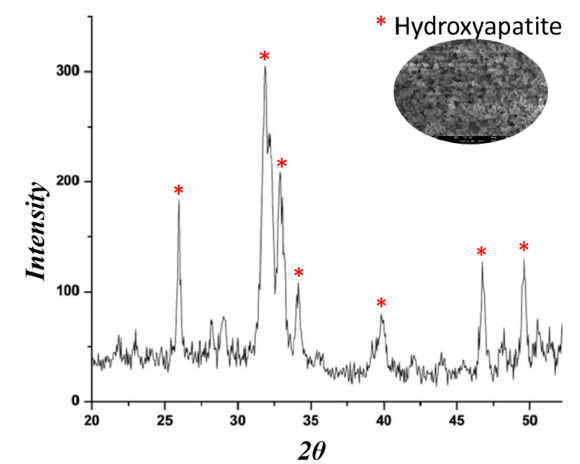
Figure 6. A representative XRD of SiO 2 /PEG 6wt% /CGA 10wt% soaked in SBF solution for 21 days.